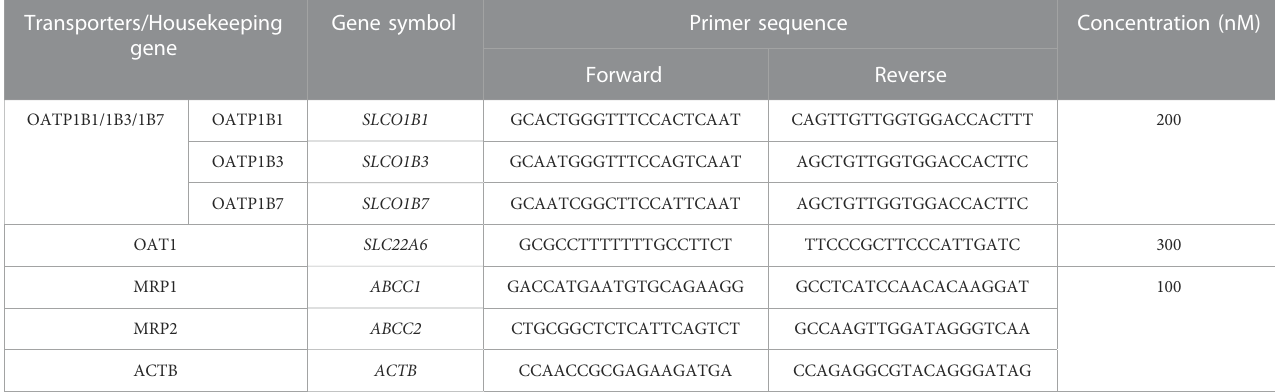
TABLE 1 Primer sequences and concentrations of the used genes.